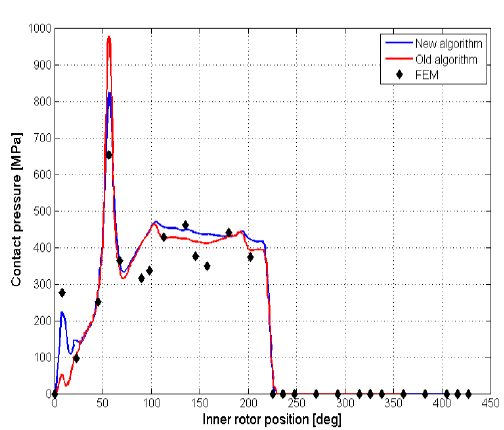
Figure 9. Contact pressures (algorithm).